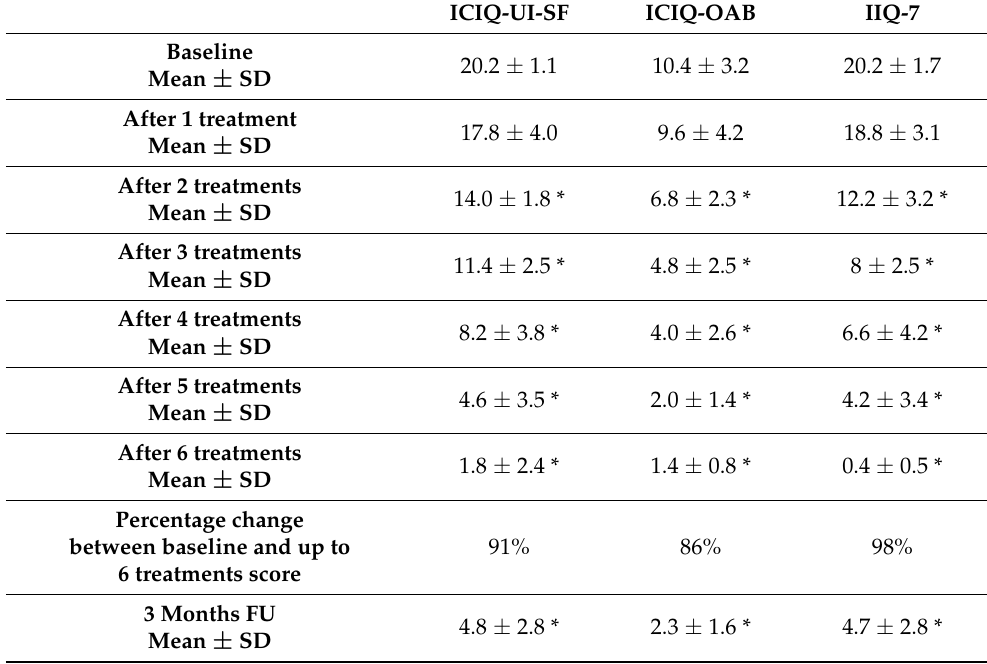
Table 3. Mean score related to ICIQ-UI-SF, ICIQ-OAB, and IIQ-7, at baseline, after each treatment session (until the 6th treatment session), and at 3 months